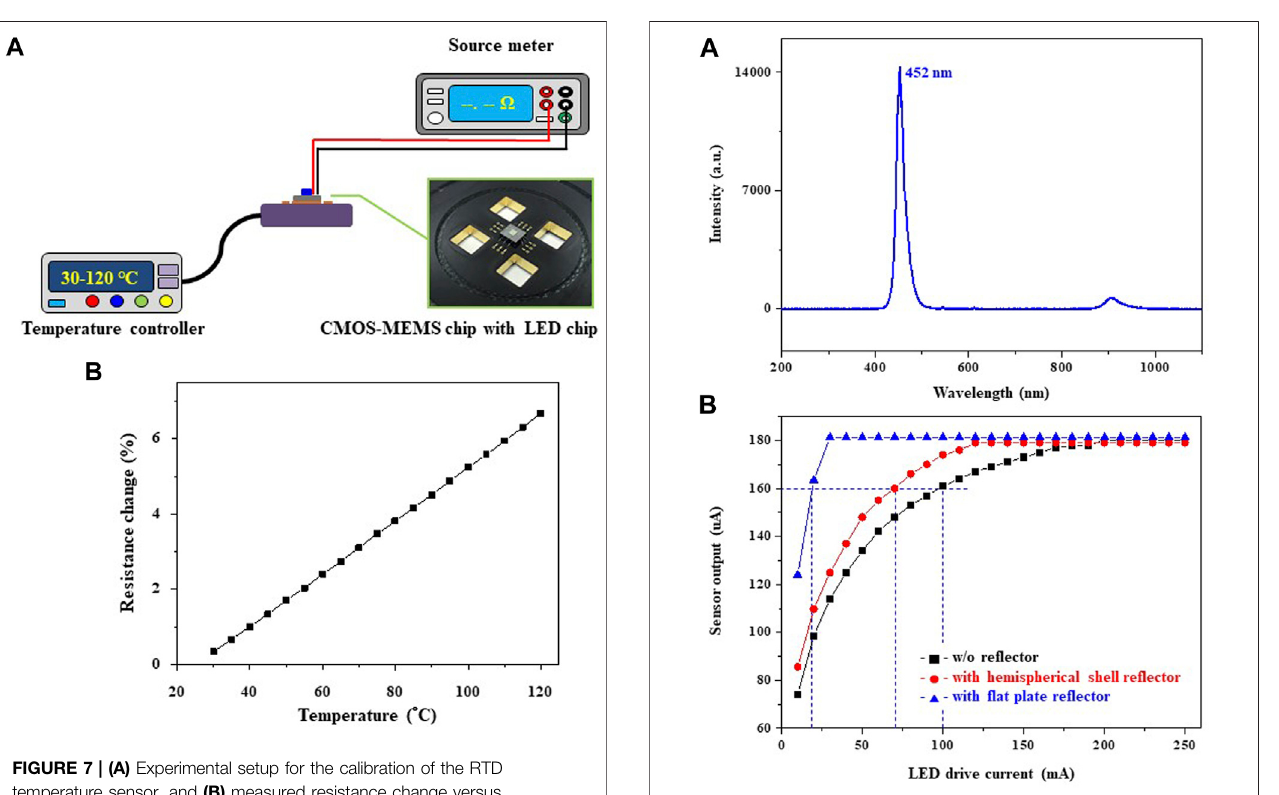
FIGURE 8 | (A) Blue LED light spectral response, and (B) the output current from photo-sensors of three different gas sensor designs varying with the driving current on the LED